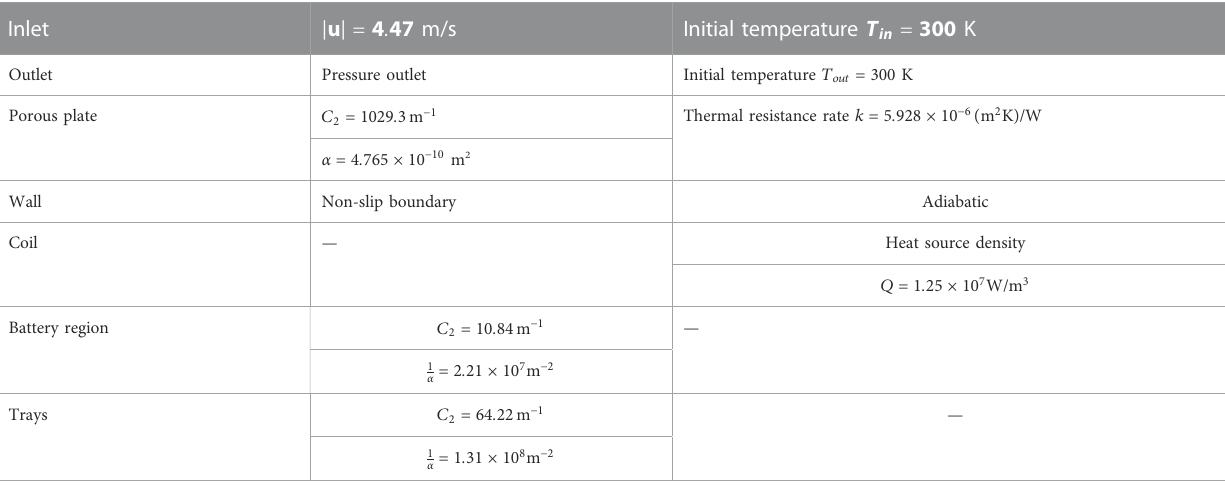
TABLE 1 Parameters obtained experimentally for boundary